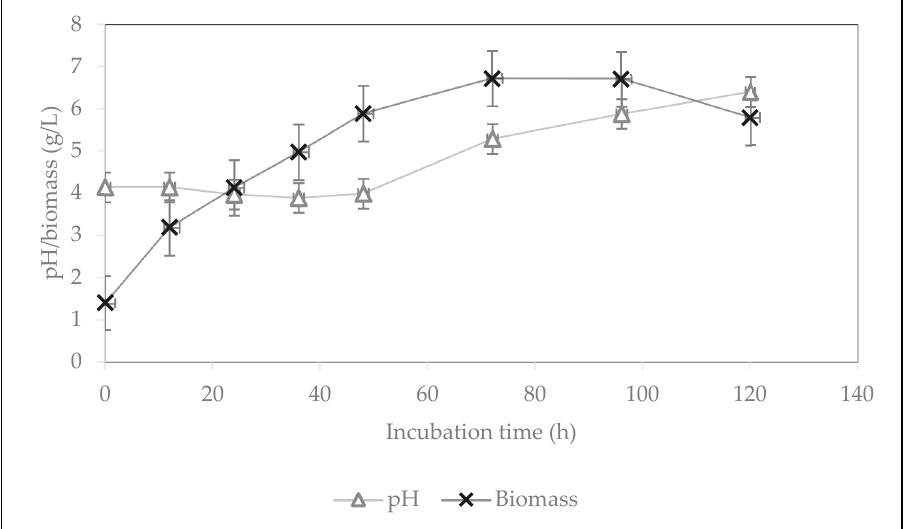
Figure 4. Biomass production and pH changes during cultivation of Rhizopus oligosporus on residual water from the first boiling of tempeh processing with the addition of yeast extract and incubation at pH 4.5 and 125 rpm.